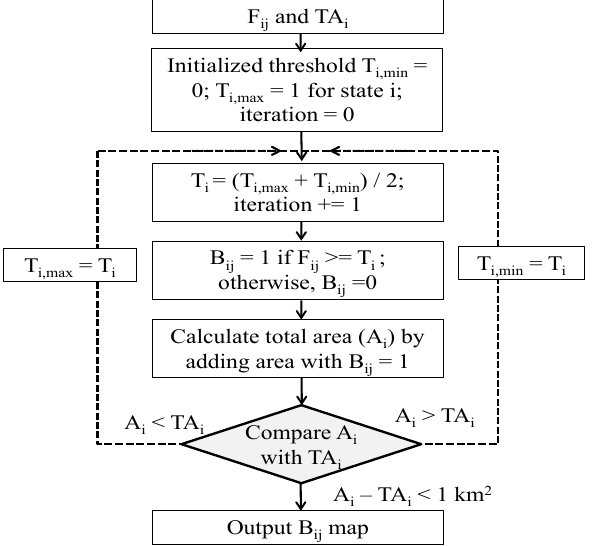
Figure 7. The procedure to identify the spatial distribution maps of plantation forests for each state based on grid cell fractional data and state-level inventory data, in which i : state, j : grid cell ID, F ij : fraction of plantation forest for grid cell j in state i , T i : calculated threshold fraction for state i , T i, max : identified maximum fraction threshold, T i, min : identified minimum threshold, B ij : plantation dis- tribution represented by Boolean values (0, 1) for grid cell j in state i , A i : calculated plantation area in state i , and TA i : targeted planta- tion area in state i .